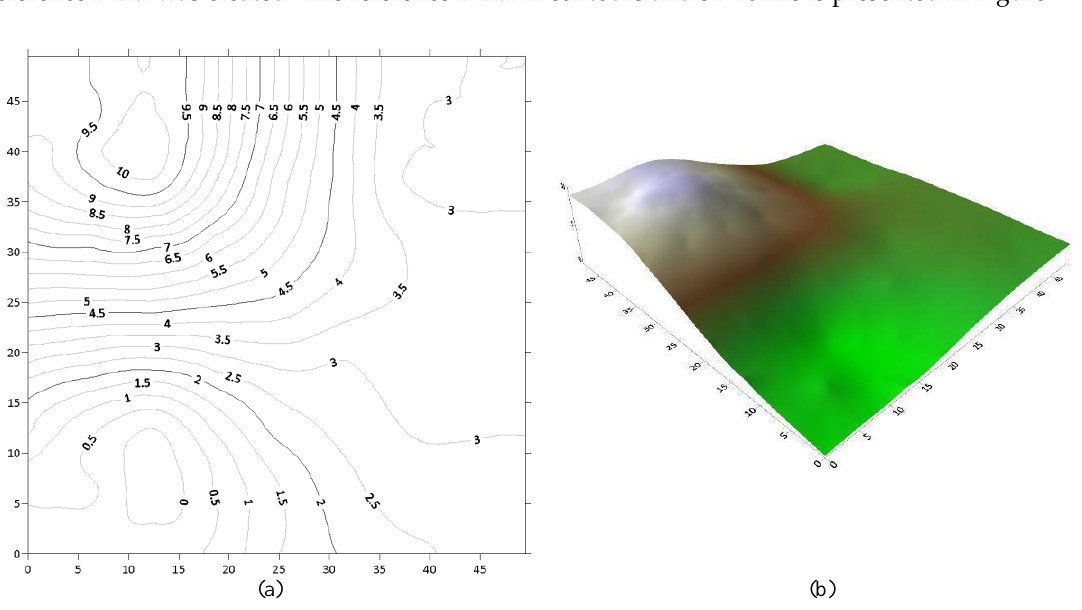
Figure 7. Contours ( a ) and 3D model ( b ) of the reference test area.